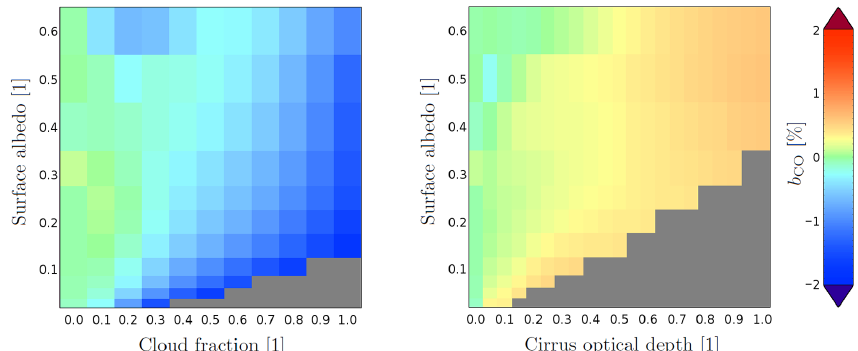
Figure 6. Left panel: retrieval bias in case of a cloud atmosphere. The CO bias is shown as a function of surface albedo A s and cloud fraction f for a cloud between 4 and 5km altitude with optical depth τ scat = 2 and a VZA of 0 ◦ . Right panel: CO retrieval bias for measurements in presence of optically thin cirrus, which overcasts the entire scene, as a function of surface albedo and cirrus optical depth that defined at 2300nm. The gray area indicates measurement simulations, which were rejected by the cloud filter.